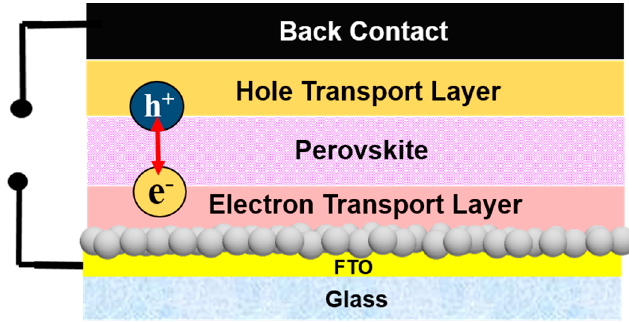
Figure 1. Schematic configuration of a typical perovskite solar cell.